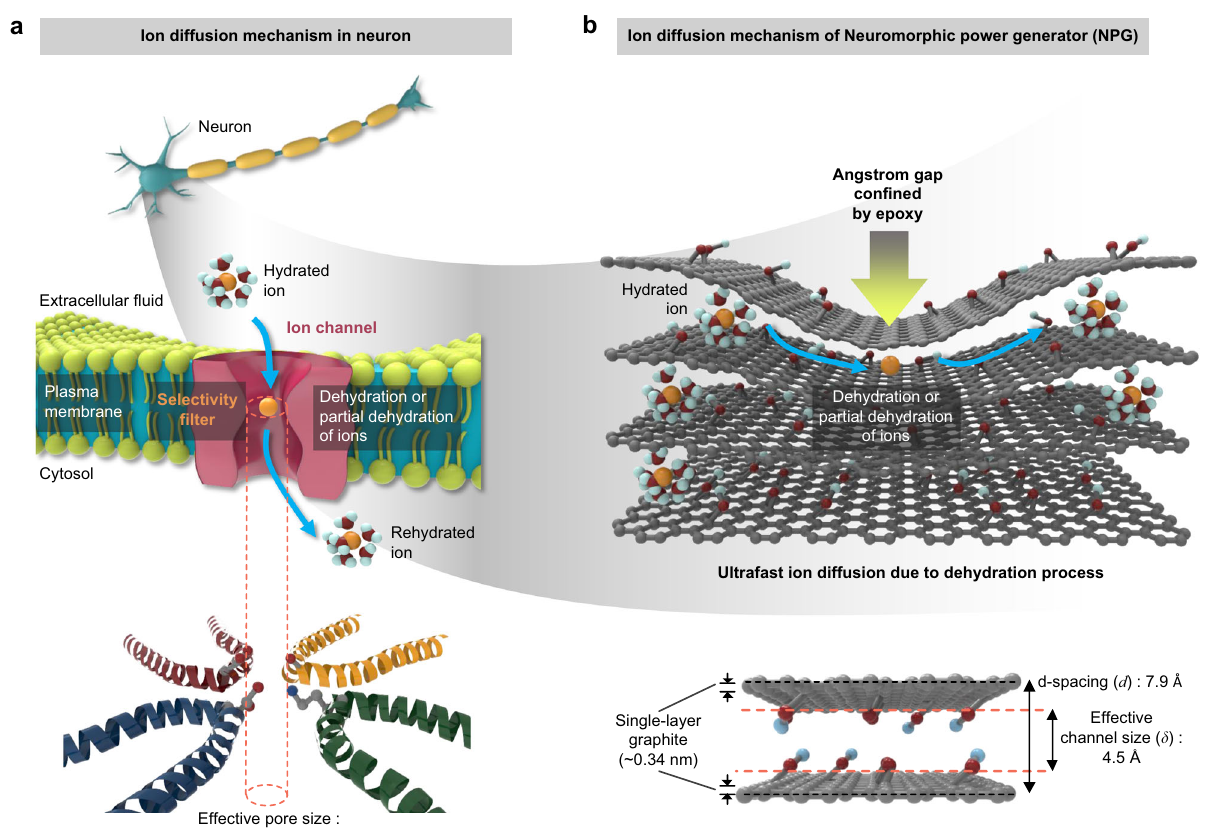
Fig. 1 Schematics of the biological ion channel and physically con fi ned graphene oxide. a Schematic of ion diffusion mechanism of biological ion channel with effective pore size. b Schematic of ion diffusion mechanism of physically con fi ned graphene oxide with effective channel